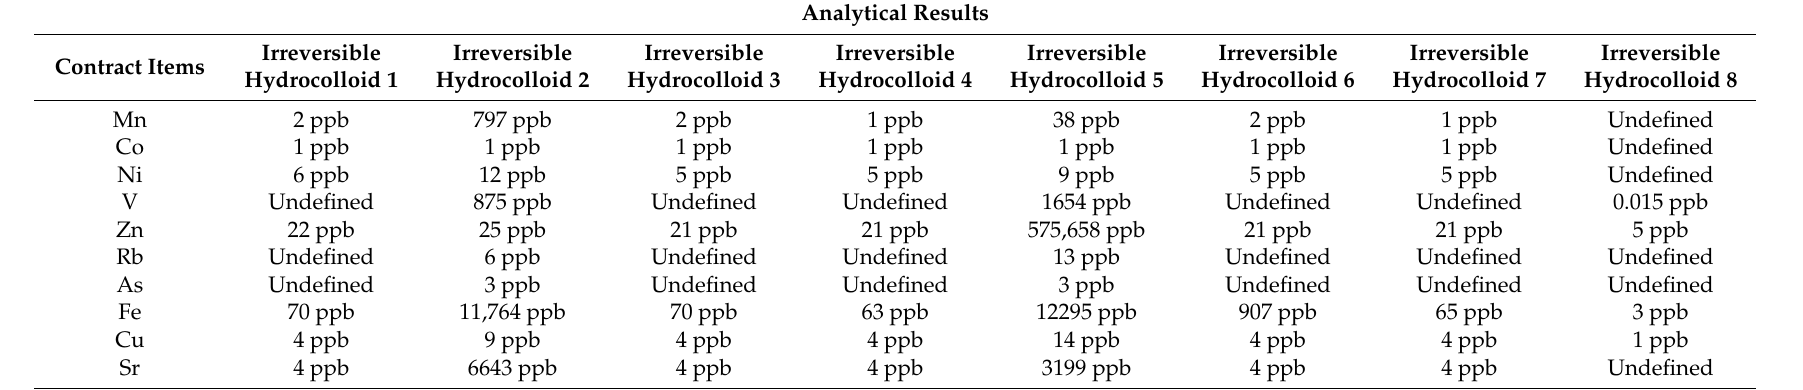
Table 2. Analytical results of the amount of Mn, Co, Ni, V, Zn, Rb, As, Fe, Cu and Sr in irreversible hydrocolloid. Analytical